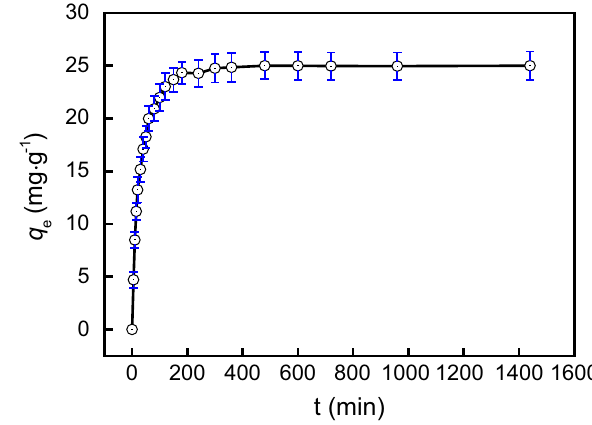
Fig. 4 Effect of contact time on the adsorption of Co(II) ion onto the DTC resin